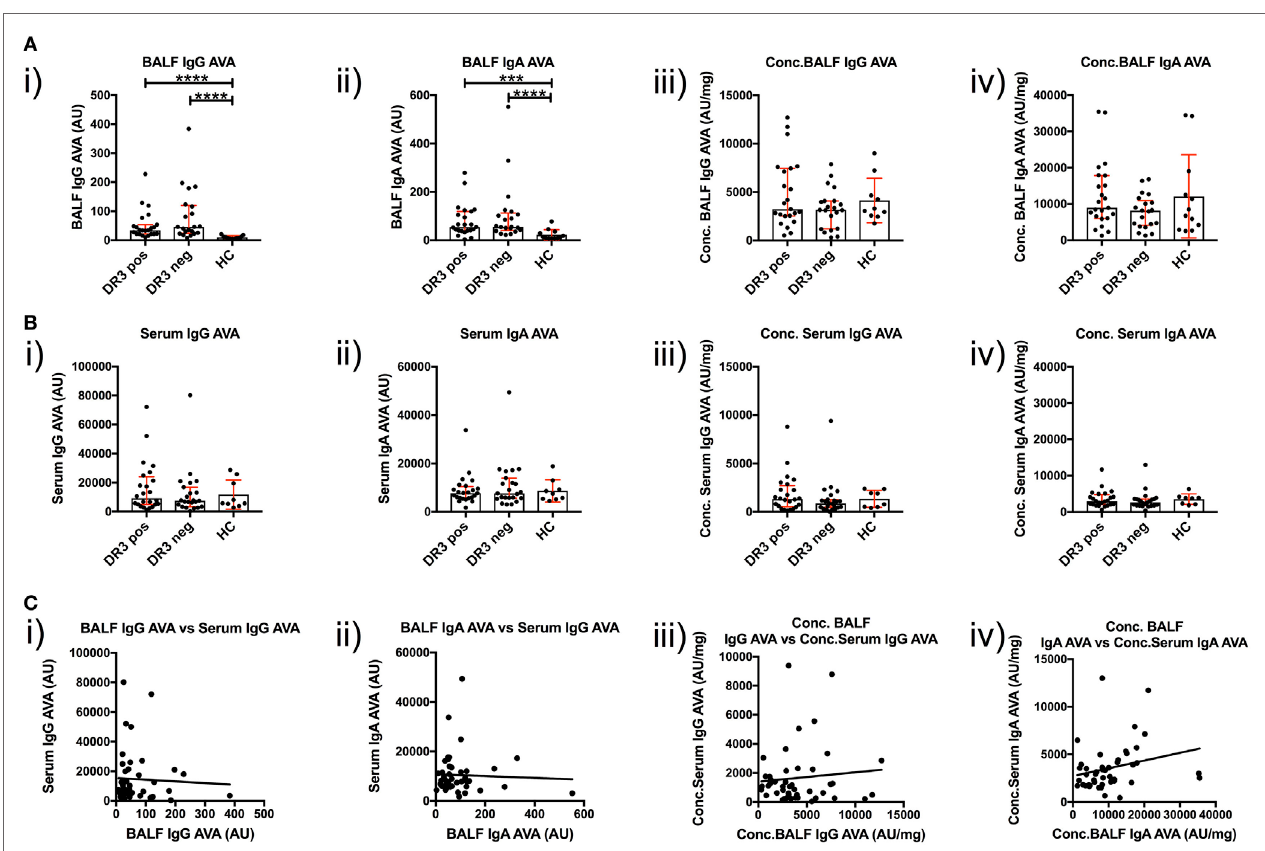
FigUre 5 | IgG and IgA titers in bronchoalveolar lavage fluid (BALF) and serum to recombinant full-length vimentin. Anti-vimentin antibodies titer differences between sarcoid patients positive and negative for HLA-DRB1*03, and healthy controls (HC), are given for BALF (a) and serum (B) as neat values [Arbitrary units (AU)] on the left (i,ii), and as concentrations of total immunoglobulin isotype (AU/mg) on the right (iii,iv). Titer comparisons between the two patient groups and HC were performed using the non-parametric Mann–Whitney U test and values presented as median with interquartile range. Statistical significances are denoted as two-tailed p -values as follows: * p < 0.05; ** p < 0.01; *** p < 0.001; and **** p < 0.0001. Spearman correlations of respective antibody titers between matched BALF and serum samples from total sarcoidosis patients (positive and negative for HLA-DRB1*03 combined) are shown in (c) for neat values (i,ii) and concentrations (iii,iv) of total immunoglobulin isotype. Lines of best-fit are shown. (i) r = − 0.020, 95% confidence interval − 0.320 to 0.283, p = 0.894; (ii) r = − 0.010, 95% confidence interval − 0.310 to 0.293, p = 0.950; (iii) r = − 0.052, 95% confidence interval − 0.348 to 0.254, p = 0.735; and (iv) r = 0.366, 95% confidence interval 0.072 to 0.601, p =